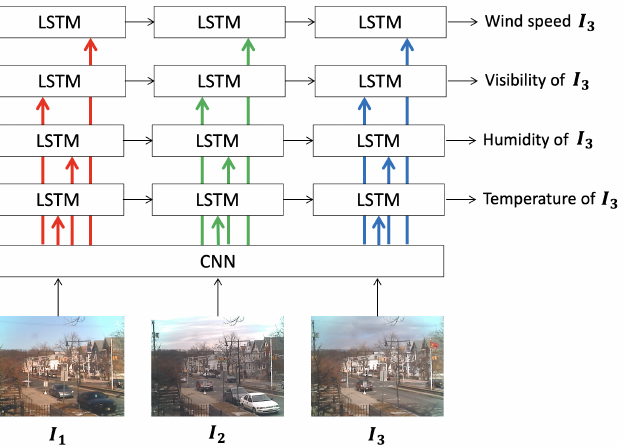
Figure 6. Illustration of the proposed network for four weather property prediction based on multi- task